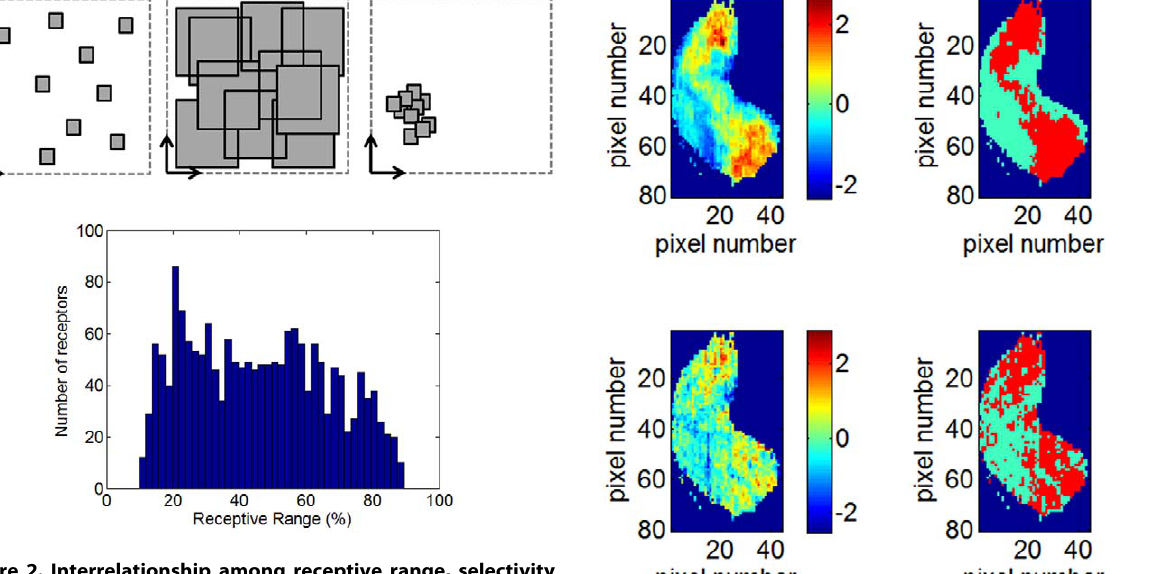
Figure 2. Interrelationship among receptive range, selectivity and correlation of olfactory receptors. Top: Selectivity and correlation of olfactory receptors. The odor space and the RR of the receptors are represented by the dashed-square and the black squares respectively. Two different 10-receptor arrays are created: with narrowly (left) and broadly (center) tuned receptors. Narrowly tuned receptors may be less correlated, while broadly tuned receptors cover a larger area of the odor space and respond to a larger number of odorants. While broad RR receptors could be more correlated (more overlap between receptors), receptors with small RR may also be correlated (right). Bottom: Receptive range distribution. Receptive range (RR) distribution for the 1,778 active receptors. More selective receptors respond to a lower number of odorants (low RR) and broadly tuned receptors show a ‘‘positive response’’ to most of the odorants (high RR). Total of different odorants tested: 339. doi:10.1371/journal.pone.0037809.g002 (right) shows the performance distribution of a 12 receptor-type ensemble.